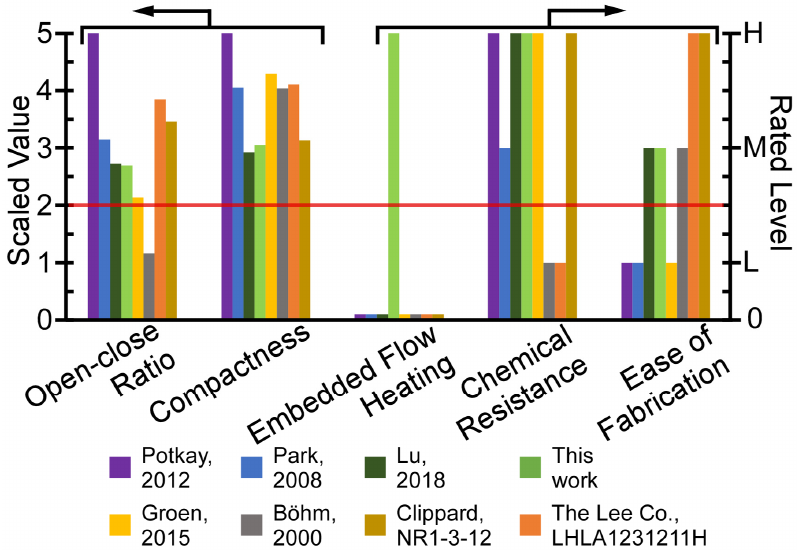
Figure 1. A multi-dimensional benchmarking of microvalves in the context of microscale gas chro- matography ( µ GC). The minimum desired level for µ GC is indicated by the red line. The microvalve module in this work uniquely provides both embedded flow heating capability and superior chemical resistance, while only modestly compromising other